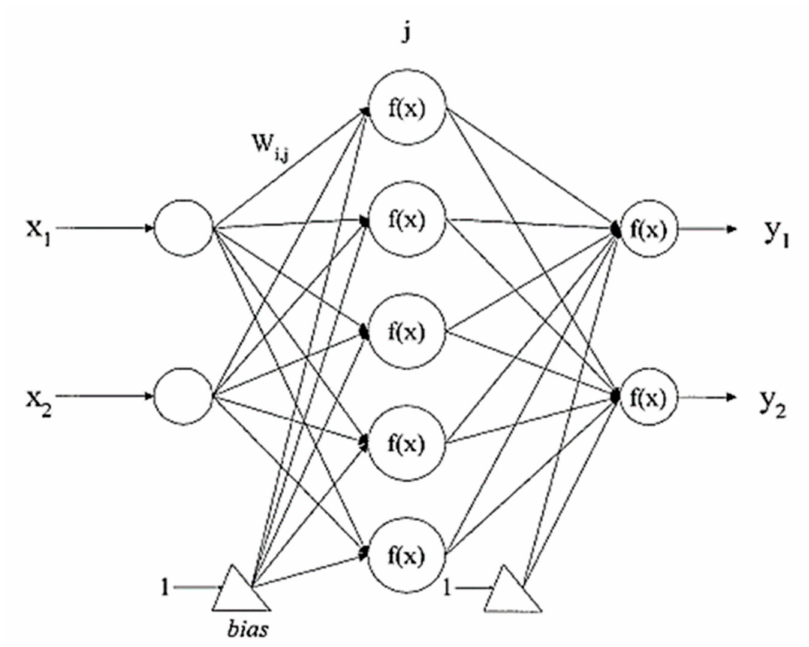
Figure 1. ANN with the interconnecting lines representing the weights associated with interconnec- tions between the neurons (Adapted from